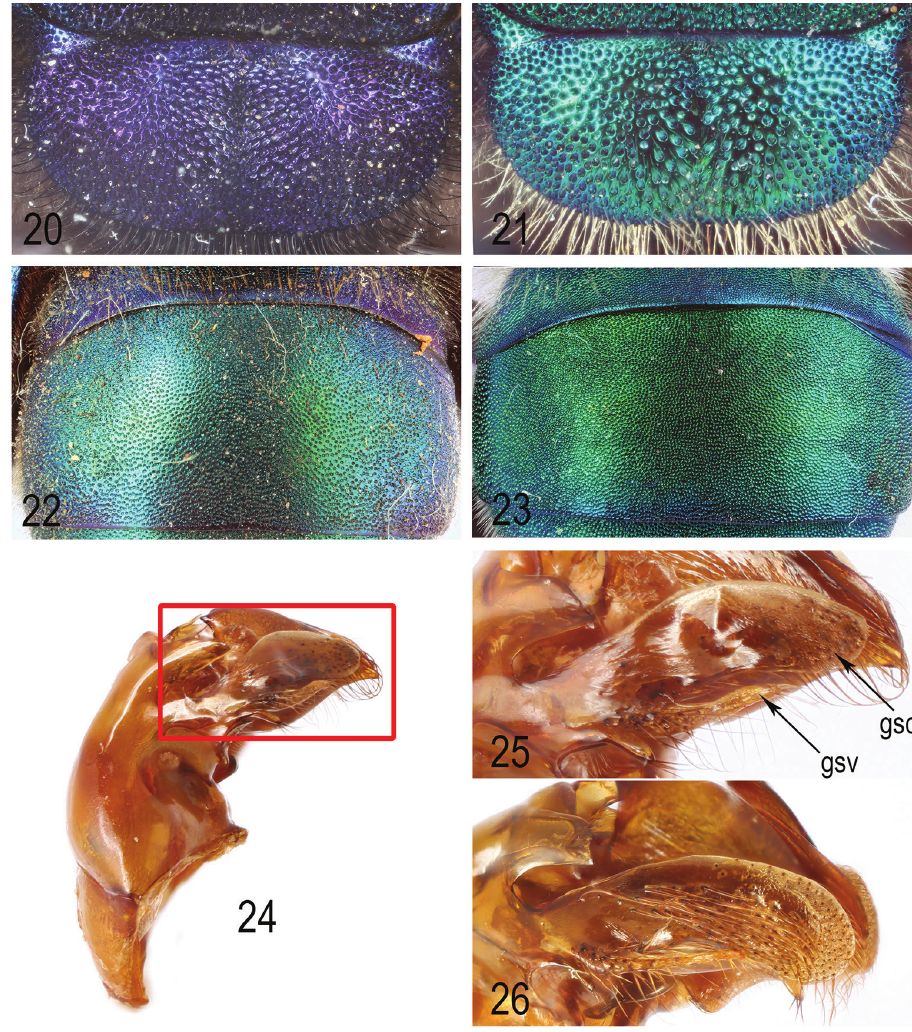
Figures 20–26. Dorsal views of male mesoscutellum ( 20, 21 ) and second metasomal tergum ( 22, 23 ), and lateral views of the genital capsule ( 24 ) and dorsal ( gsd ) and ventral lobes ( gsv ) of the gonostylus ( 25, 26 ). Red box in Fig. 24 indicates detailed area in subsequent figures. 20 E. micheneri (paratype. Mexico: Jalisco, Talpa, KUNHM-ENT 1121712) 21, 23–25 E. oliveri (paratype. Mexico: Guerrero, EMEC 1069134, -35) 22 E. coerulescens (lectotype) 26 E. engeli (paratype, KUNHM-ENT